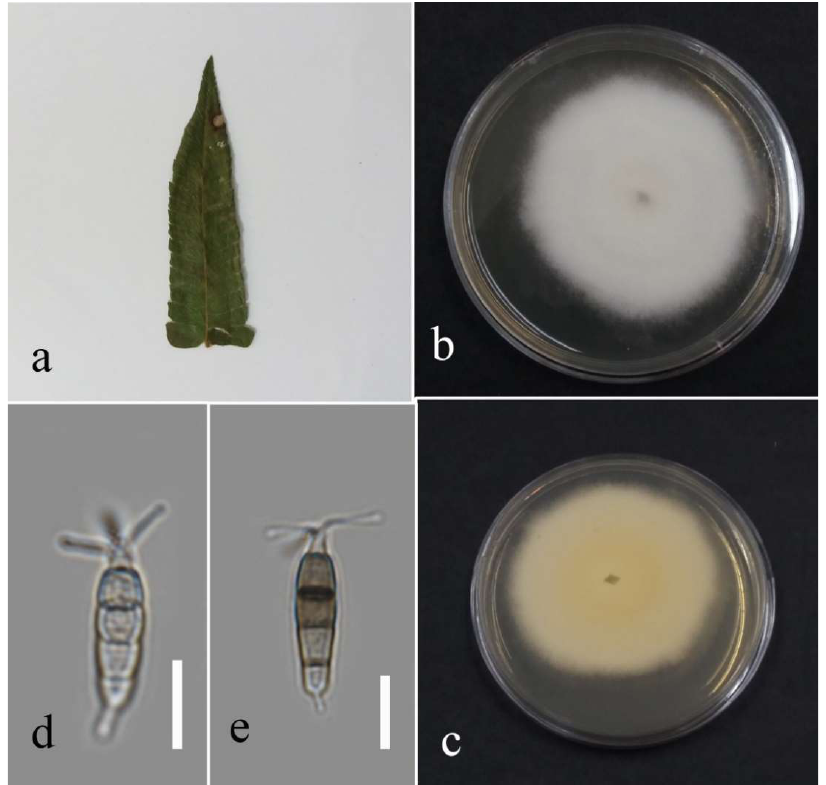
Figure 7. Morphology of Neopestalotiopsis hydeana (MFLUCC 22-0149): ( a ) necrotic spot in Cyclosorus sp.; ( b , c ) upper and reverse views of the colony after seven days of growth on PDA at 28 ◦ C; ( d ) immature conidium; ( e ) mature conidium. Scale bars = 10 µ